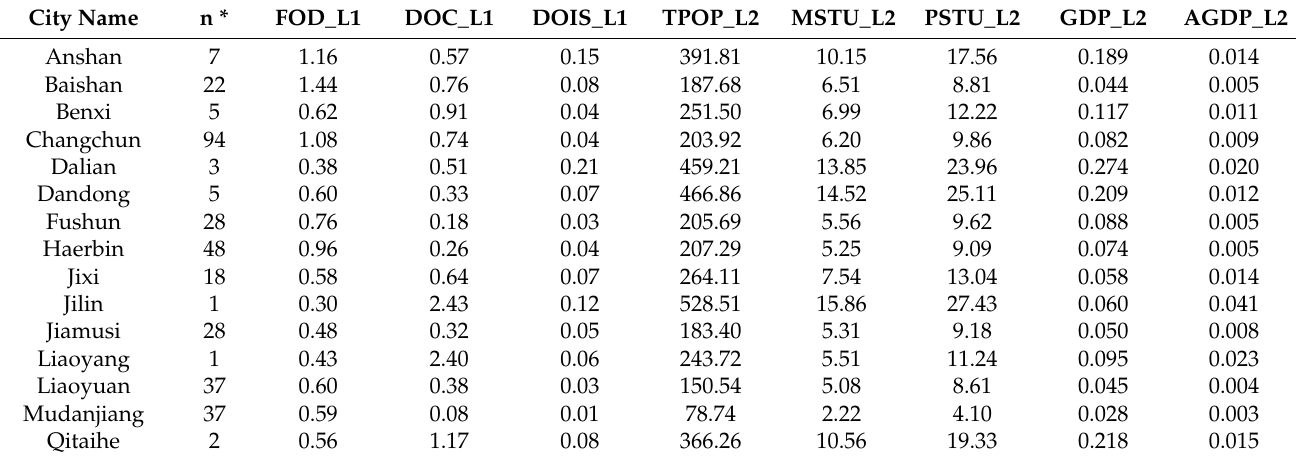
Table 2. The samples in the dataset used in the HLM and the mean value of the